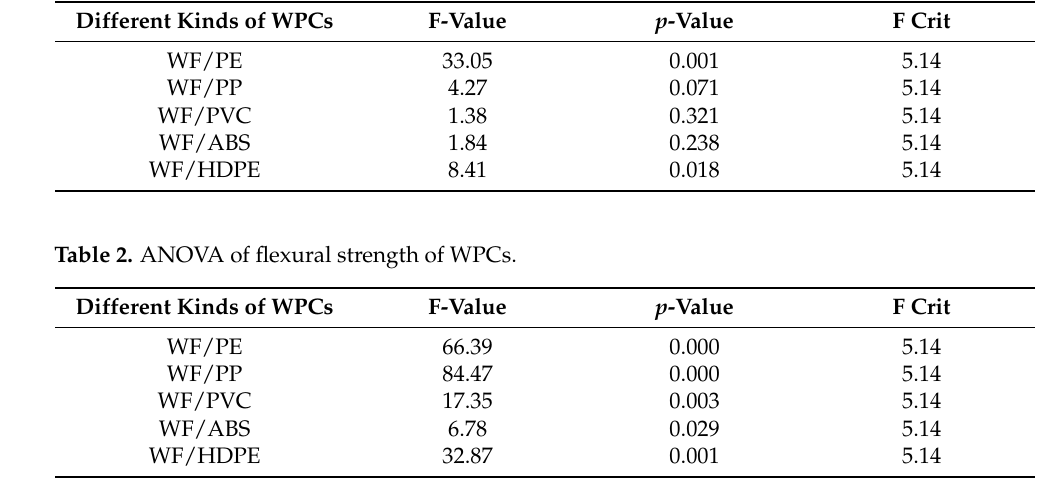
Figure 4. ( a ) Flexural stress – strain curves of WPC, MDF and HDF. ( b ) Flexural strength of WPC. ( c ) Flexural modulus of WPC. Table 1. ANOVA of tensile strength of WPCs.